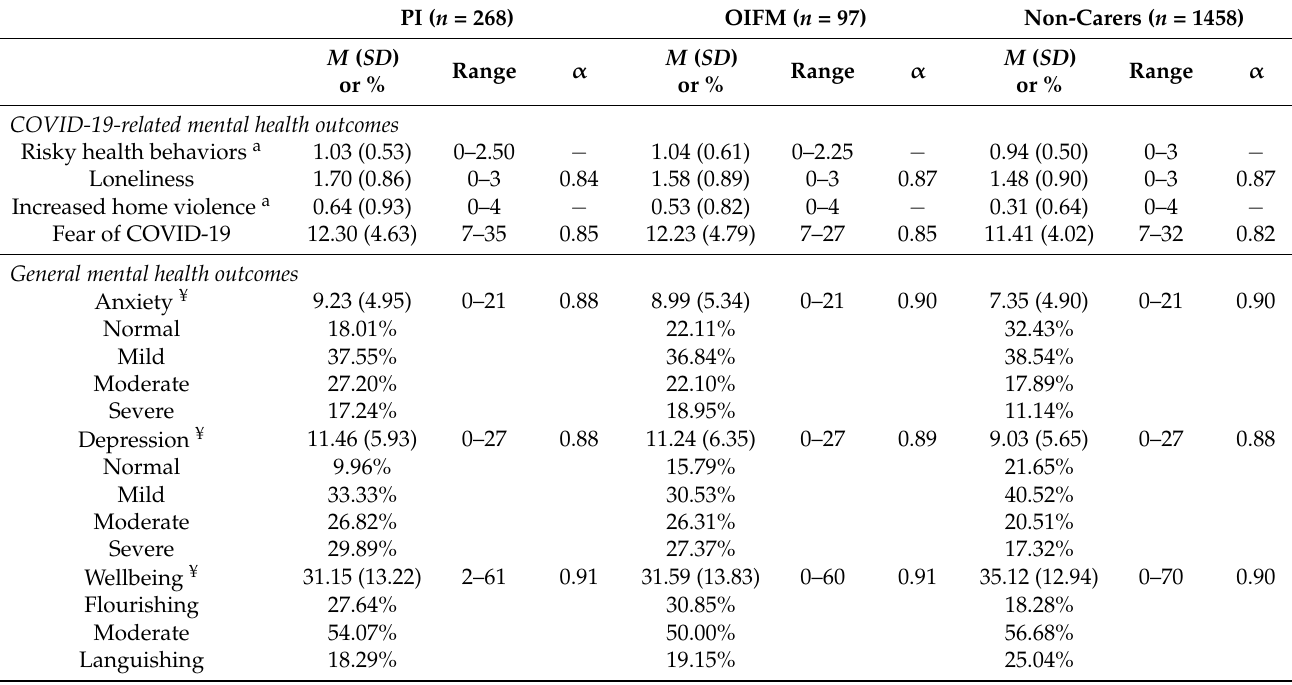
Table 2. Descriptive data on COVID-19-related mental health and general mental health outcomes in the parental illness group (PI), other ill family member (OIFM) group, and non-carer